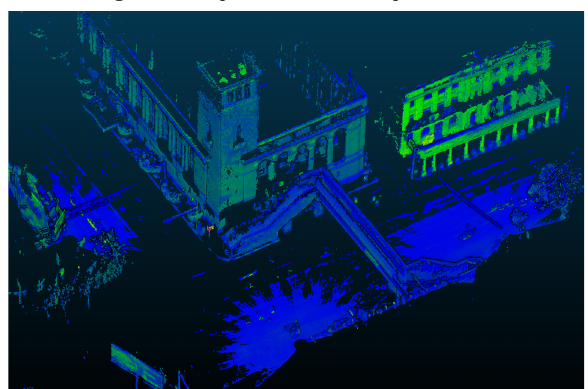
Figure 10. Top view of test scan point cloud